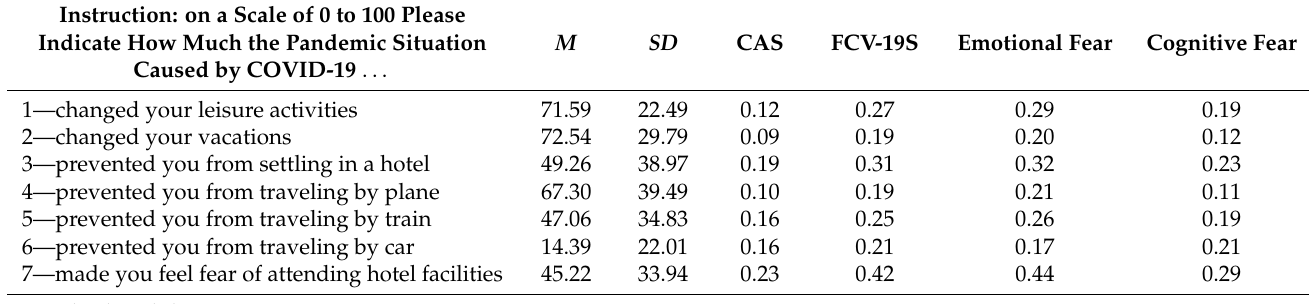
Table 3. Mean of COVID-related impediments and its Pearson correlations with CAS and FCV-19S. Instruction: on a Scale of 0 to 100